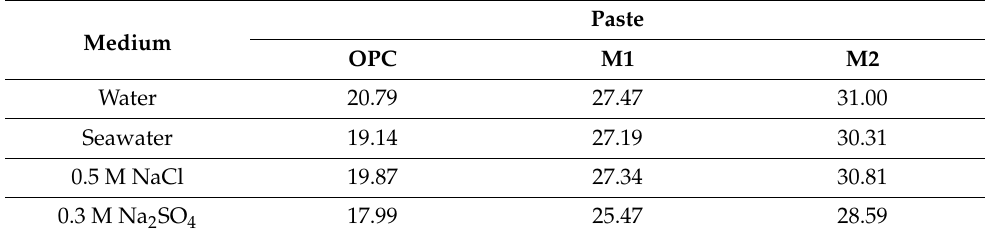
Table 4. Total porosity (vol.%) in 56-d pastes.